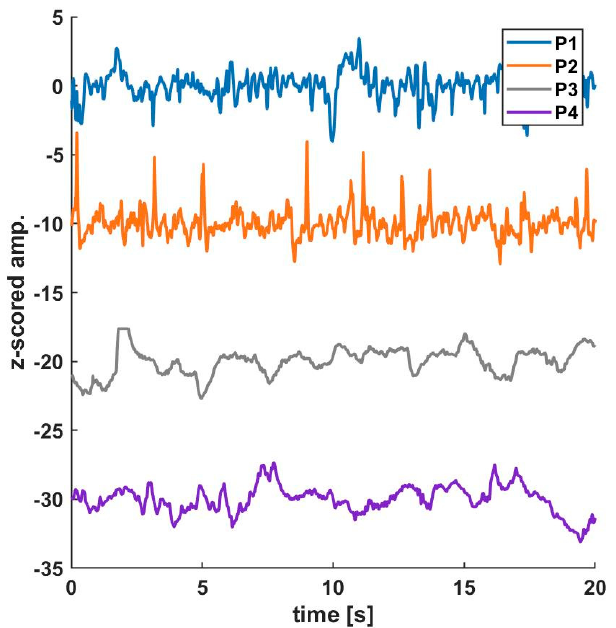
Figure 3. An exemplary EEG raw trace of all four stages was taken from a horse undergoing soft tissue surgery (horse #4).